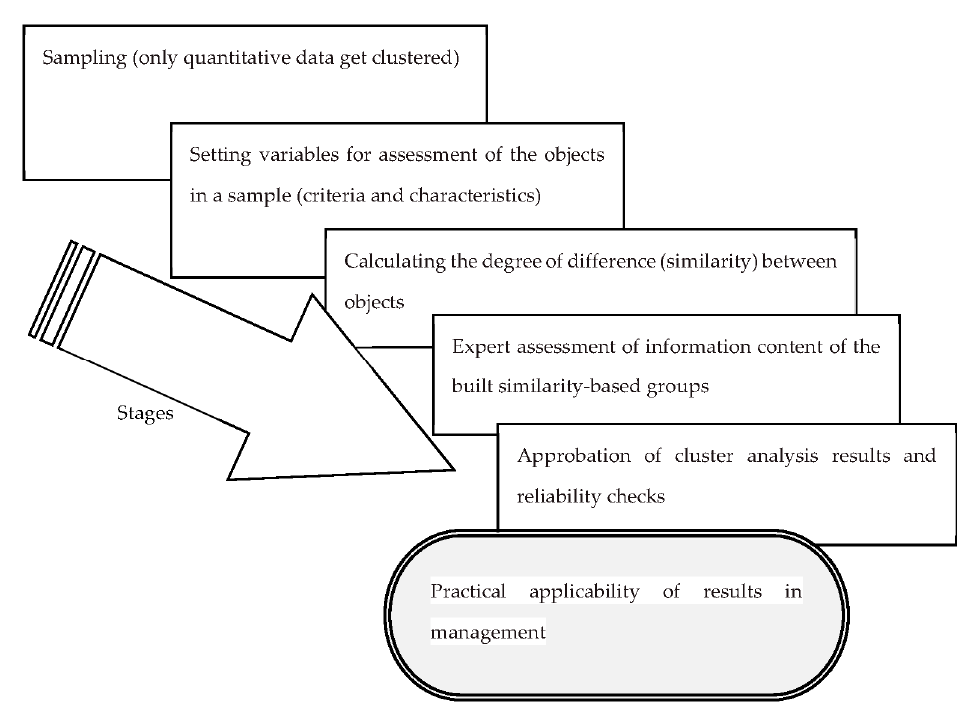
Figure 2. Stages of cluster analysis according to (Mizikovskii and Pivkin 2013).